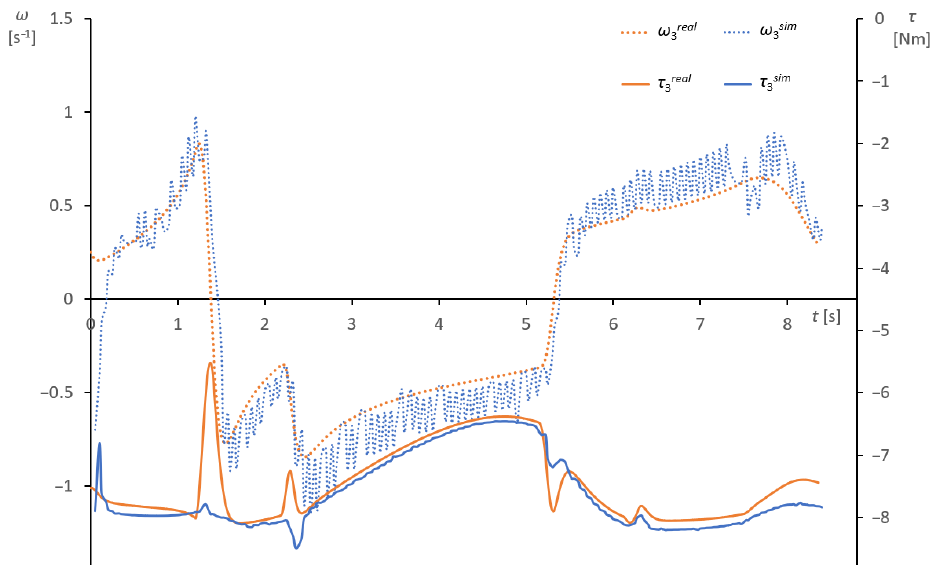
Figure 10. Comparison of the real and simulated values of angular velocity ω 3 and torque τ 3 of the third joint during the whole trajectory B1. ( a ) Robot placed in the best location. ( b ) Robot placed in the worst